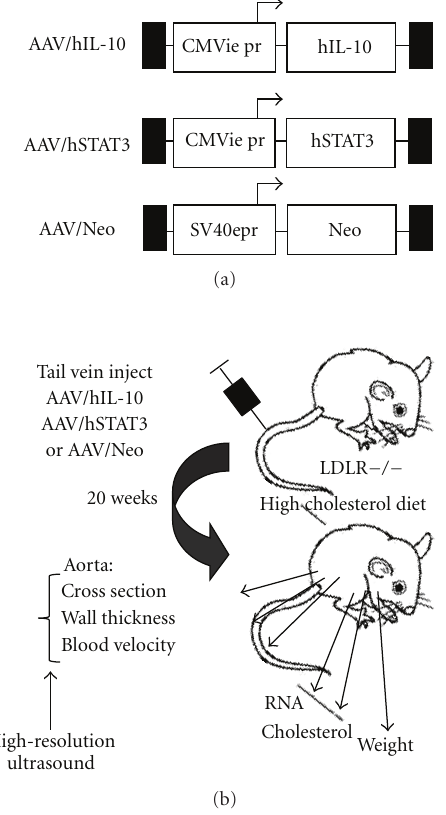
Figure 2: Structure of AAV vectors and experimental scheme. (a) shows the basic structure of the three AAV vectors used in this study. (b) shows the experimental scheme and data collected.